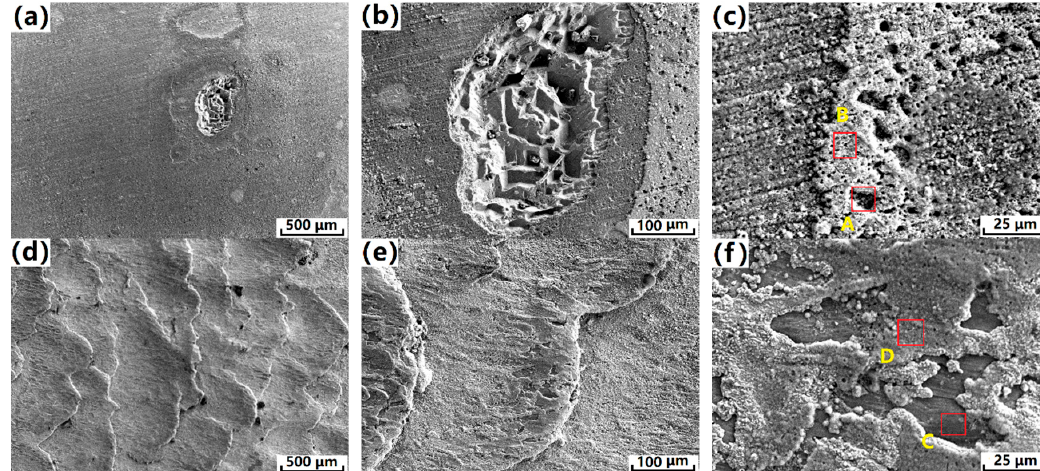
Figure 10. Scanning electronic microscopy (SEM) corrosion morphologies of the Conform ( a – c ) and Conform + SNC ( d – f ) Cu-Mg alloys’ immersion in 0.1 M NaCl solution for 30 days. ( a ) and ( d ) are low-magnification images, ( b ) and ( e ) are medium-magnification images, and ( c ) and ( f ) are high- magnification images.